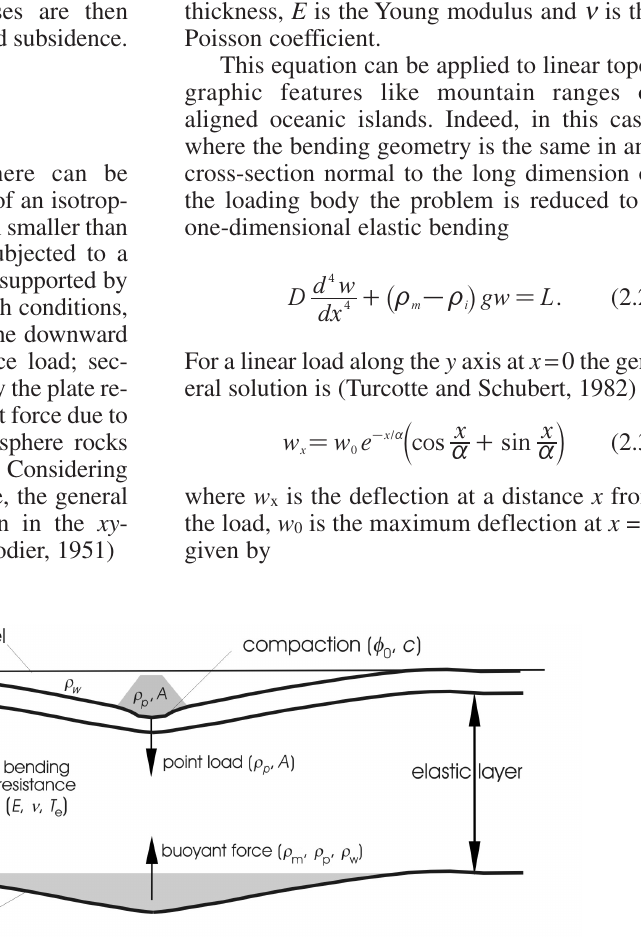
Fig. 1. Simplified sketch of the numerical model used to estimate the subsidence induced by the growth of a carbonate platform: deflection and compaction processes occurring within the elastic and plastic layers, respec- tively, are indicated along with the main parameters. E : Young modulus; ν : Poisson coefficient; T e : equivalent elastic thickness; ρ w : water density; ρ p : platform rock density; A : platform dimensions; ρ m : mantle